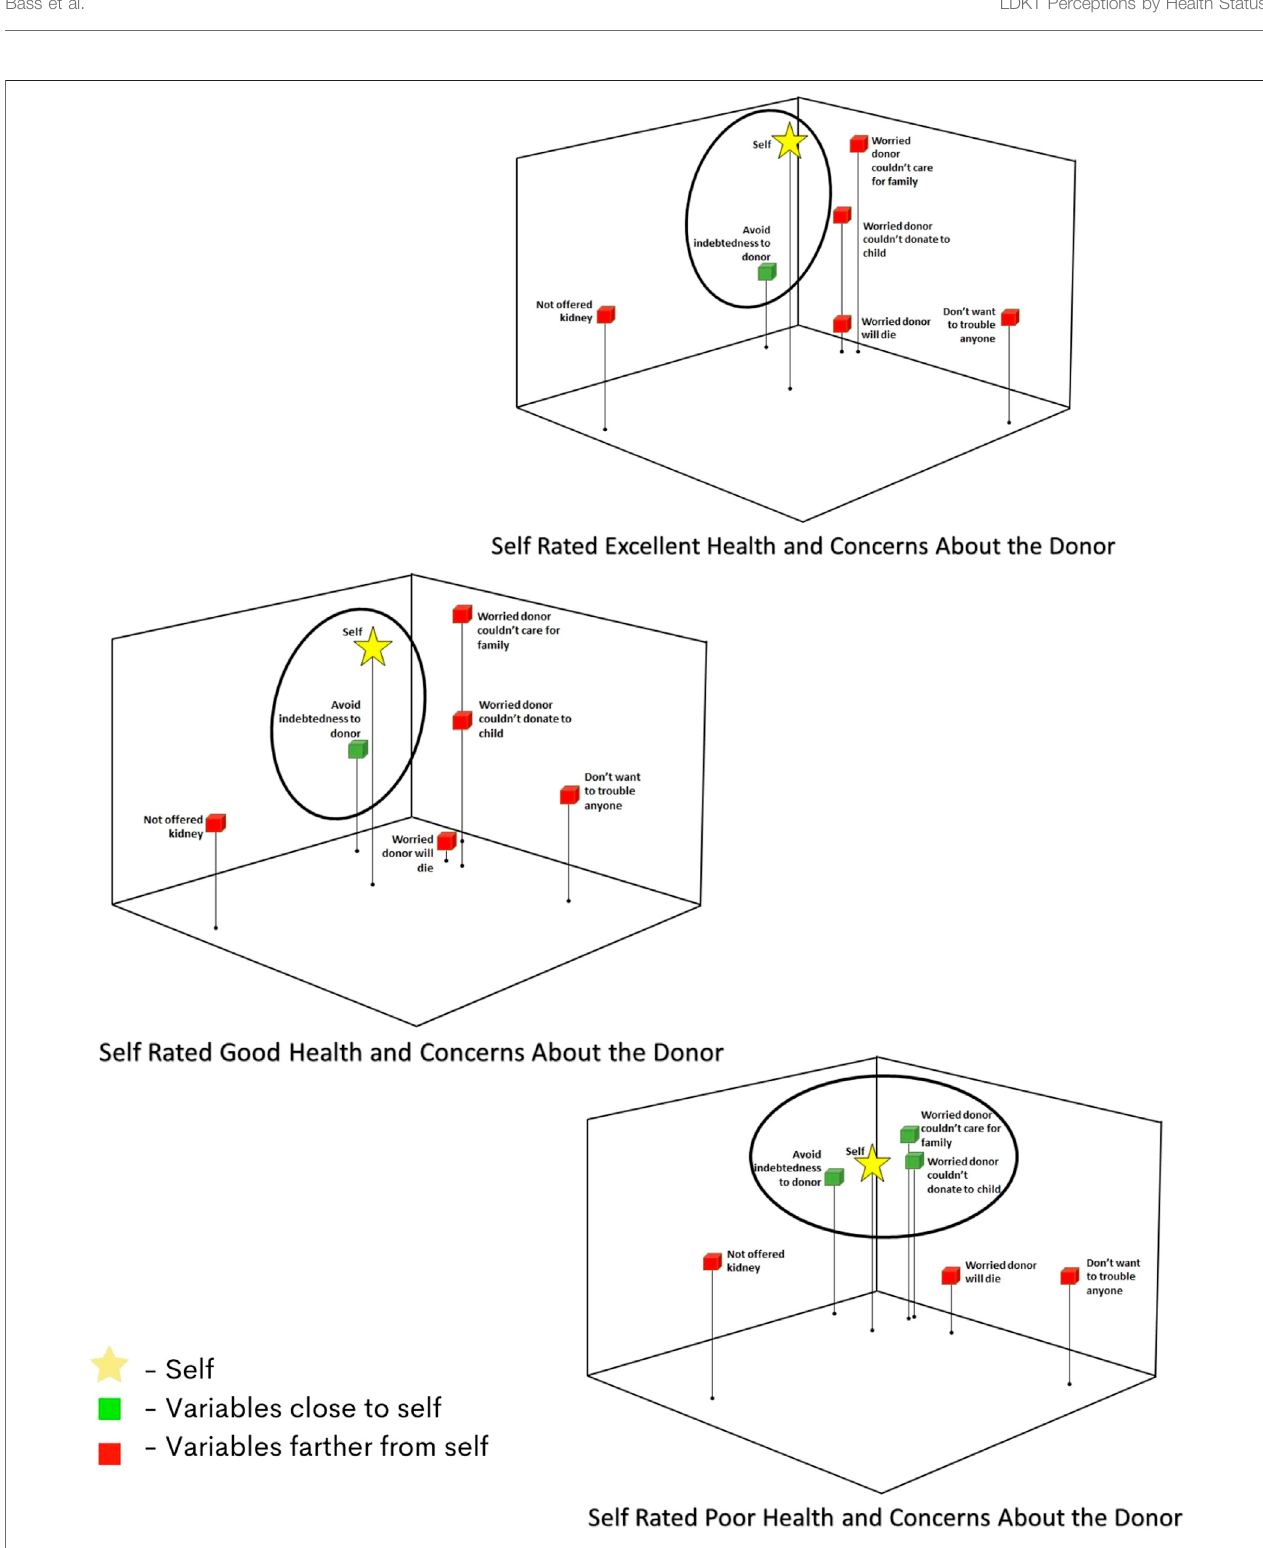
FIGURE 2 | Perceptual maps for concerns about the donor by self-reported health status.